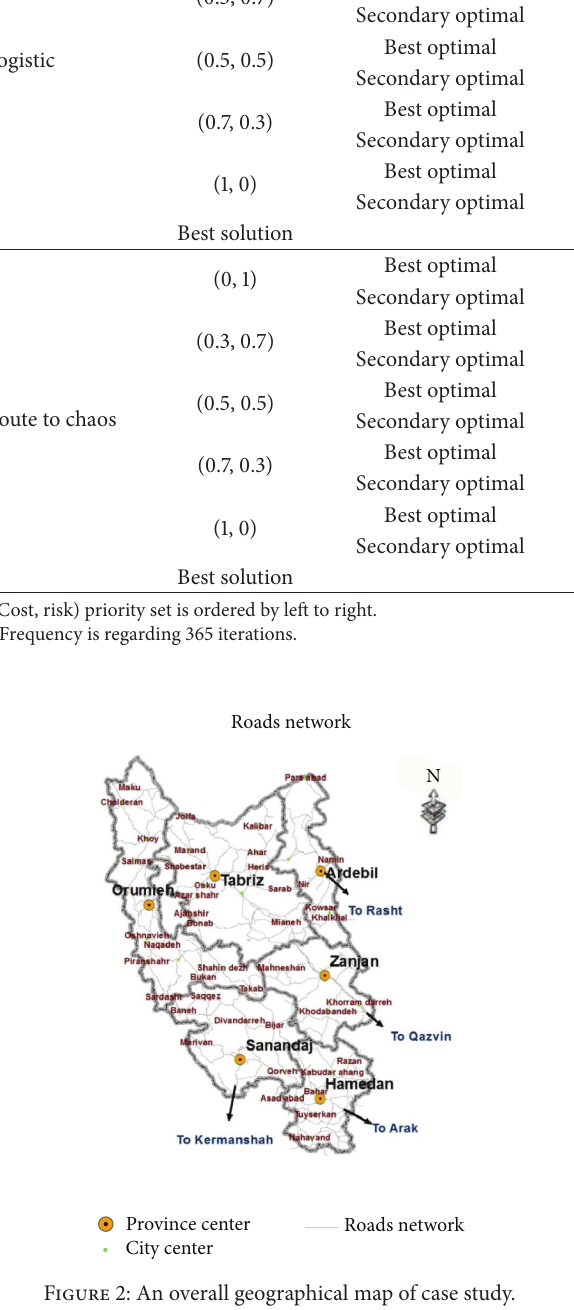
Figure 2: An overall geographical map of case